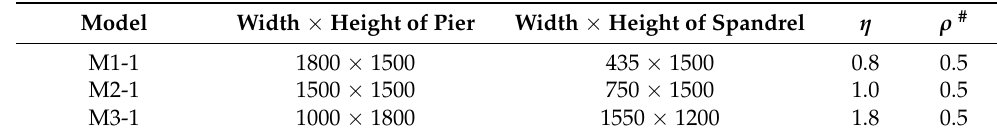
Table 2. Partial design parameters of M1, M2 and M3 (unit: mm).